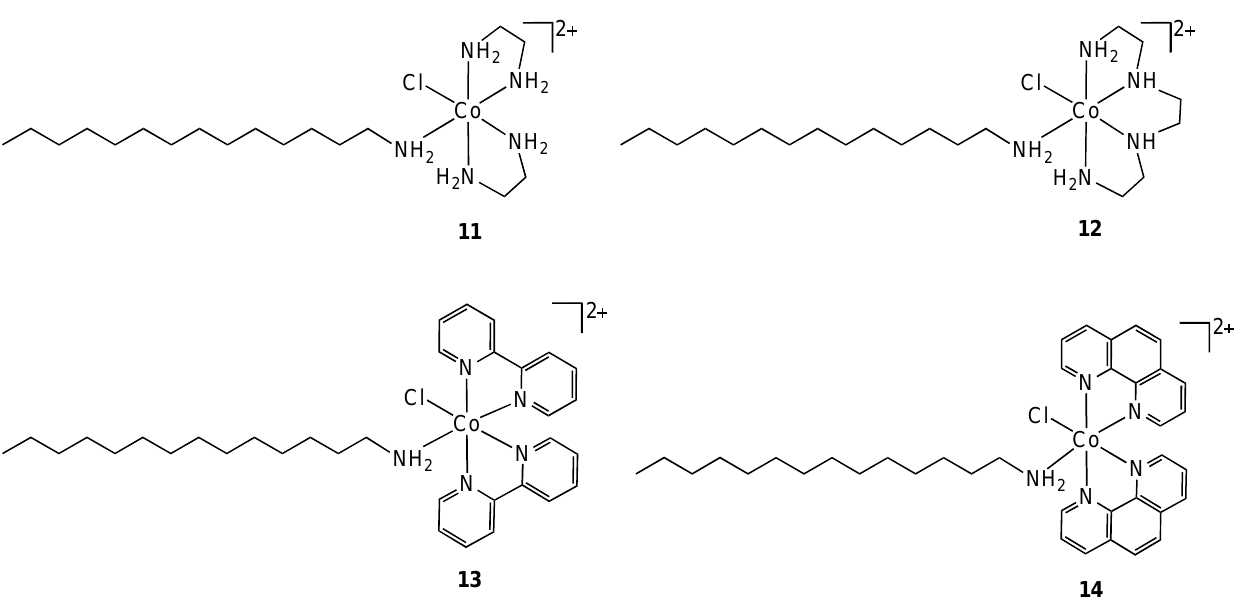
Figure 8. Cobalt(III) containing metallosurfactants.